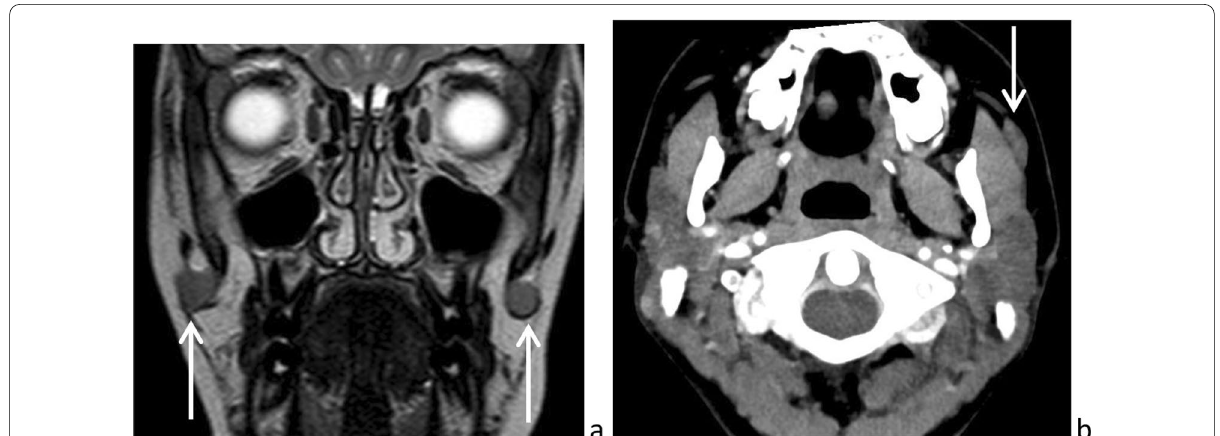
Fig. 2 Accessory parotid glands on frontal T 2 ‑weighted image ( a ) and axial CT after intravenous injection of contrast medium ( b )